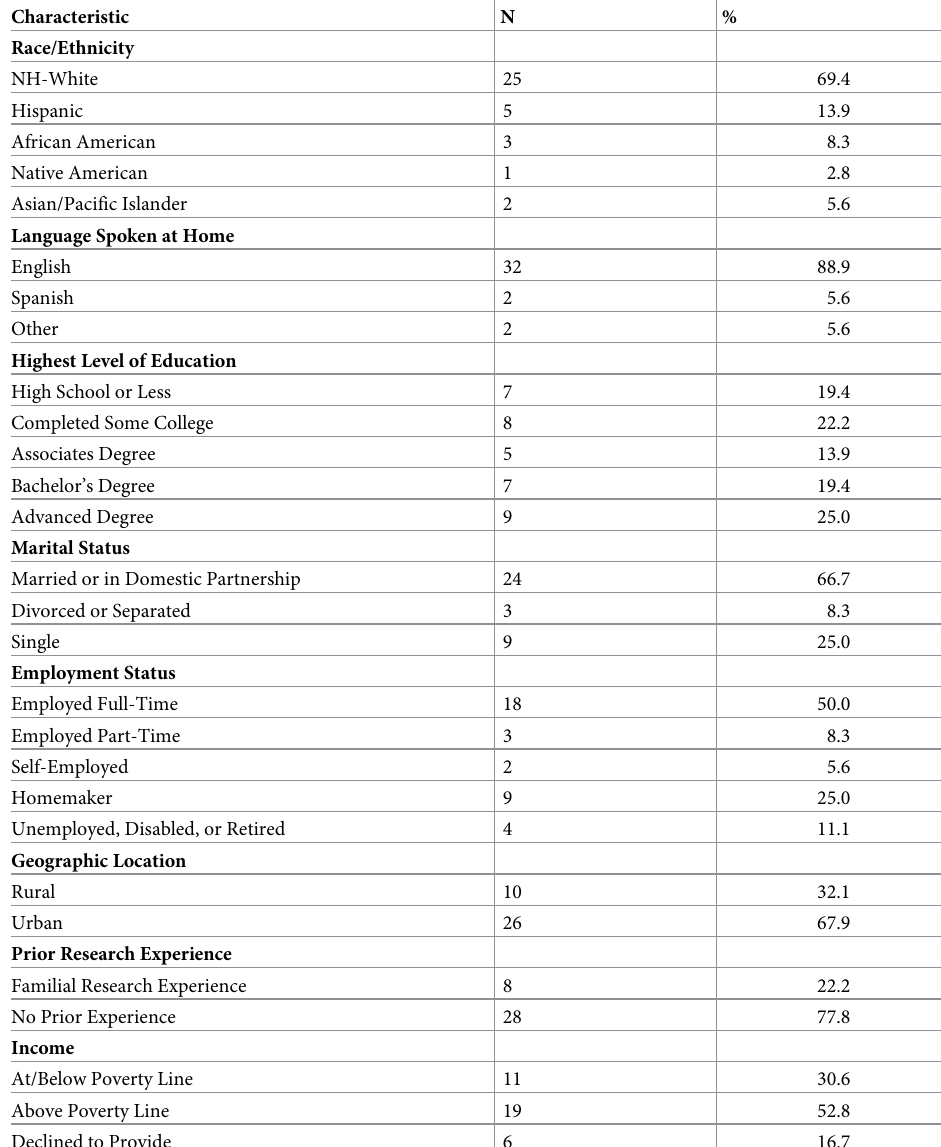
Table 1. Demographic